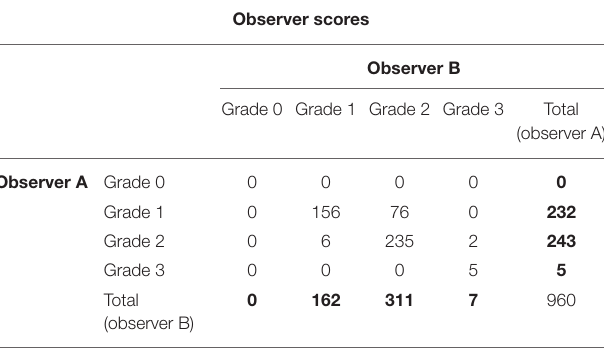
TABLE 1 | The frequency of suspensory ligament branch (SLB) grades given by independent evaluation of two blinded observers (observer A and B) are shown.